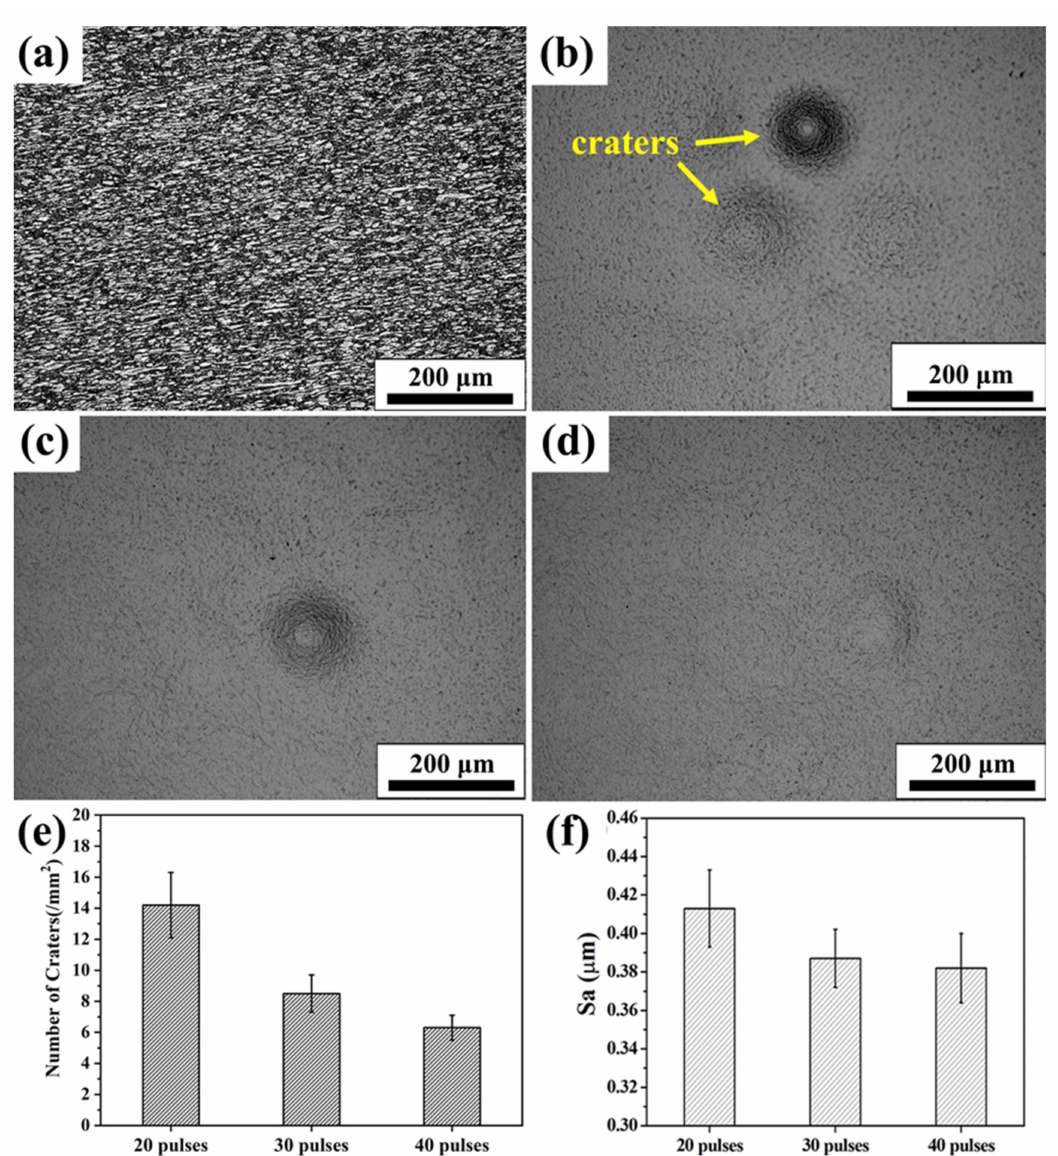
Figure 2. OM images, crater density and surface roughness of initial and Nb-alloyed samples. ( a ) Initial; ( b ) 20 pulses; ( c ) 30 pulses; ( d ) 40 pulses; ( e ) Number of craters; ( f ) Surface